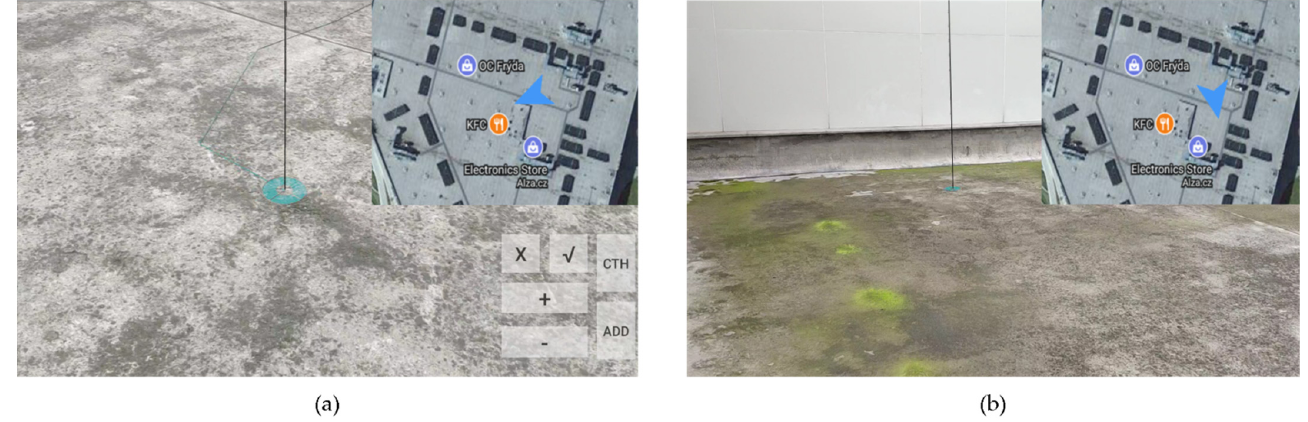
Figure 11. Capturing points on the specified 3D plane: ( a ) snapping to a point in a 3D plane (short distance); ( b ) snapping to a point in a 3D plane (far distance).